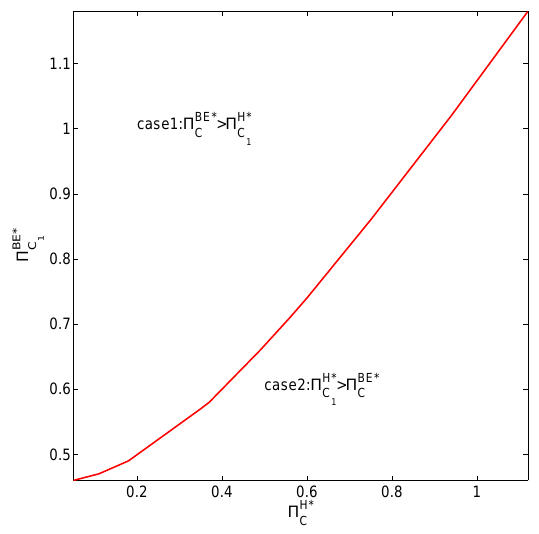
Figure 12. Regions comparing profit of the collectors with innovation input with respect to K